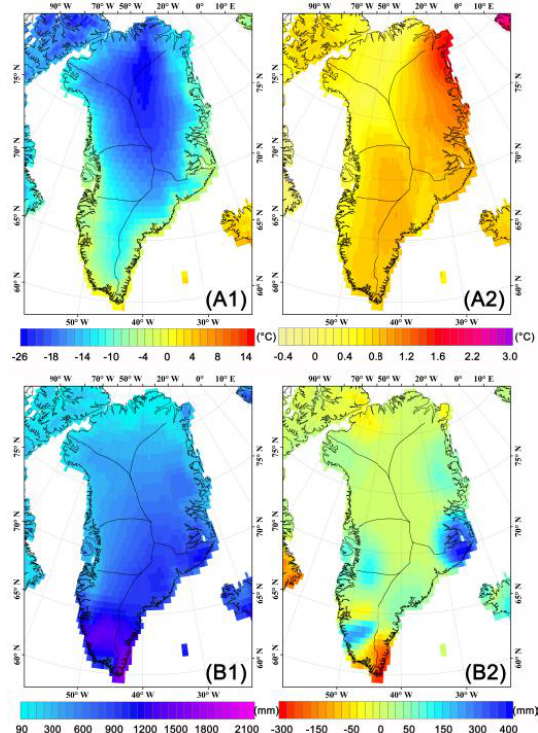
Figure 5. The difference annual mean temperature of Greenland between two time periods ( A1 ) and Figure5. Thedi ff erenceannualmeantemperatureofGreenlandbetweentwotimeperiods( A1 )and( A2 ), ( A2 ), and the annual difference precipitation of Greenland two time periods ( B1 ) and ( B2 ), were and the annual di ff erence precipitation of Greenland two time periods ( B1 ) and ( B2 ), were generated generated from the differences between the two periods 1990s and 2010s (Mean T/P2011-2018 minus from the di ff erences between the two periods 1990s and 2010s (Mean T / P2011-2018 minus Mean Mean T/P1991-2000) based on the Climatic Research Unit (CRU) TS4.03 dataset T / P1991-2000) based on the Climatic Research Unit (CRU) TS4.03 dataset (https: // catalogue.ceda.ac.uk / ). (https://catalogue.ceda.ac.uk/).